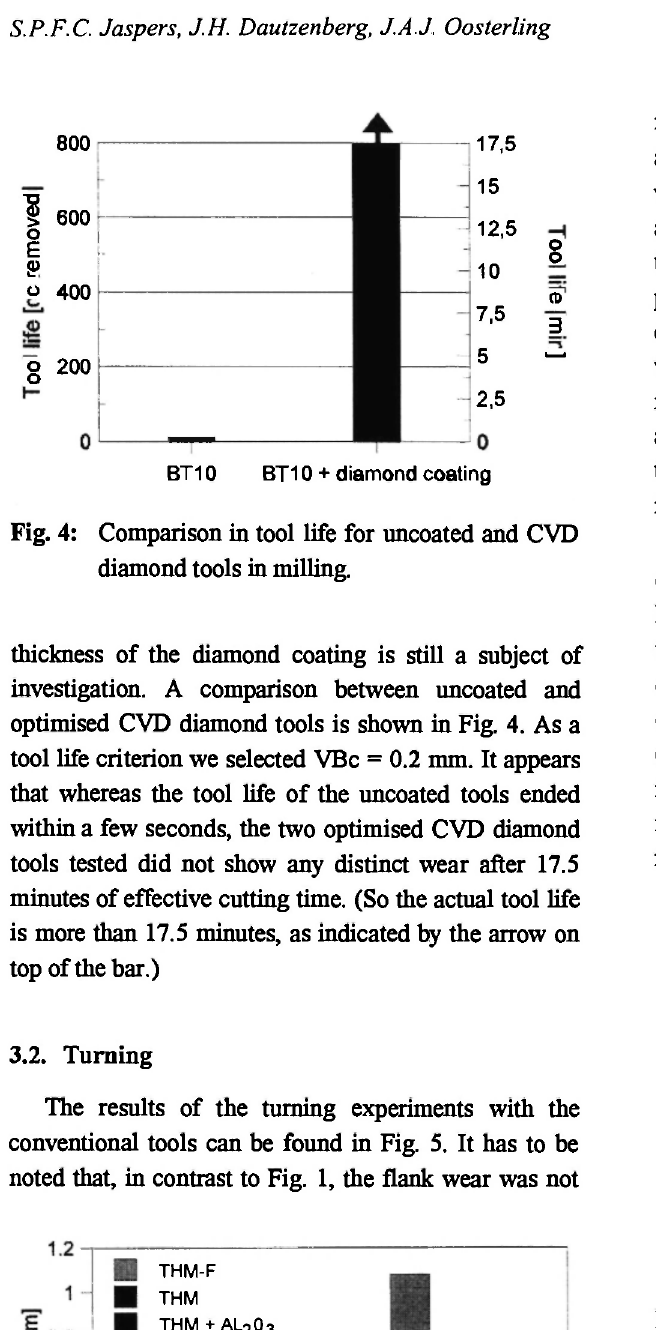
Fig. 6: Comparison in tool life for uncoated and CVD diamond tools in